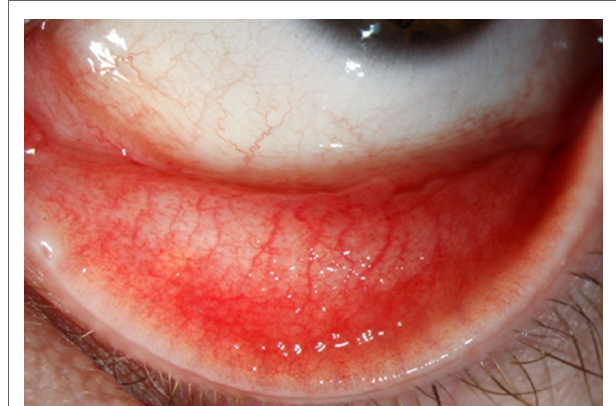
FIGURe 1 | Follicular conjunctivitis in the conjunctiva tarsi of the patient’s left eye.